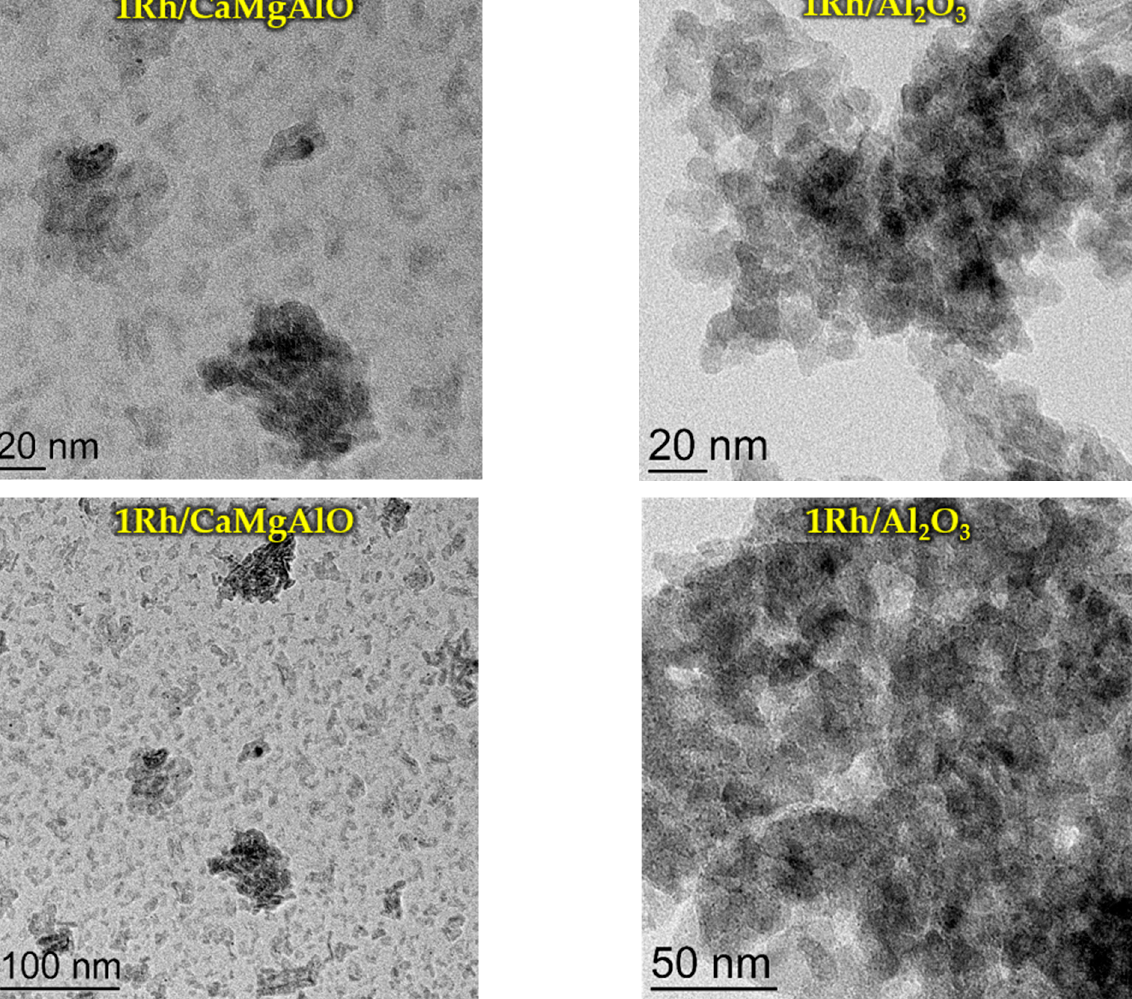
Figure 8. TEM images of the reduced H 2 catalysts with Al-containing supports.